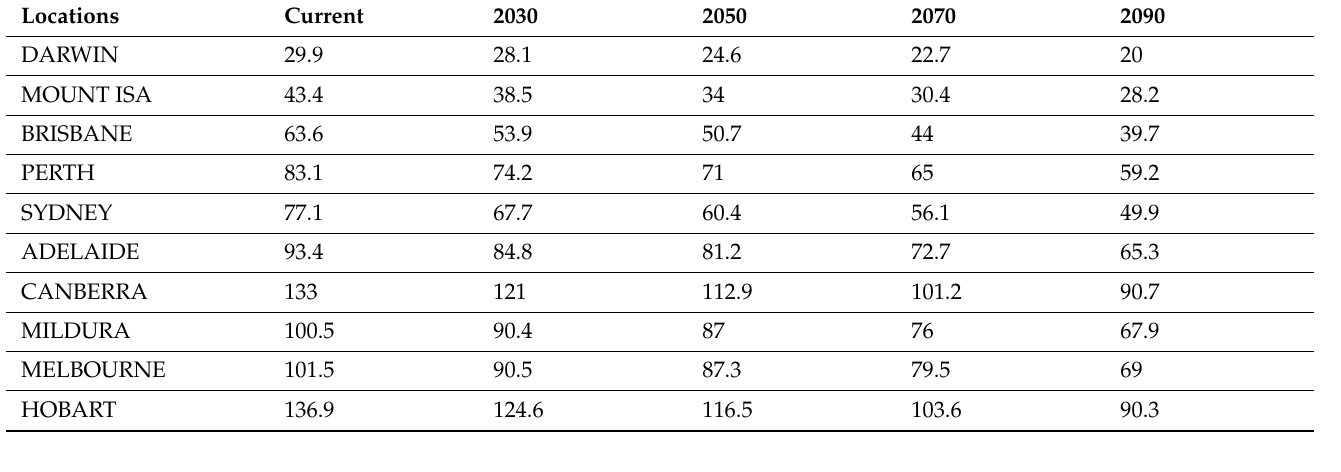
Table 9. Small hospital’s yearly boiler heating energy needs in kWh/m 2 .